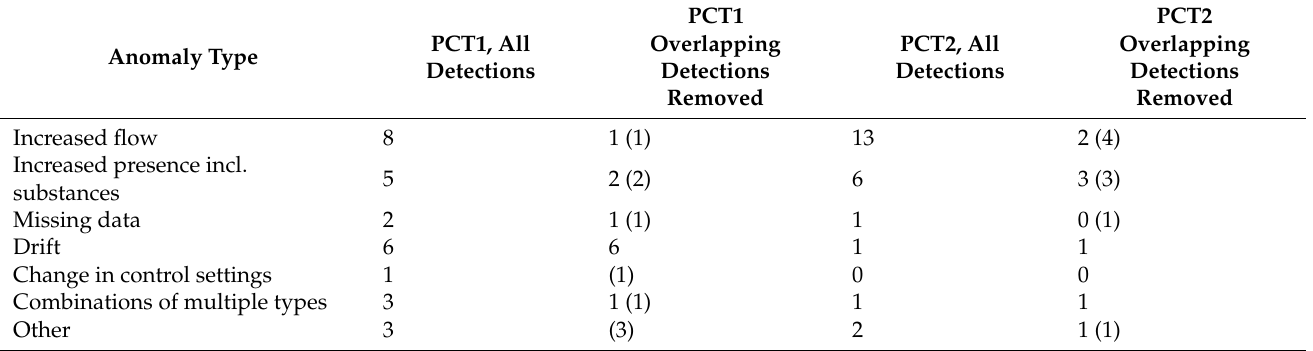
Table 3. Overview of anomaly types detected in WWTP2 for the two PCTs. The table shows how many of the different types of anomalies are detected in total for each of the PCTs. Furthermore, it shows how many anomalies are detected if anomalies present in both PCTs are removed. The numbers in parentheses are the number of anomalies which have some overlap with the other PCT, but the period of the detections is not similar.